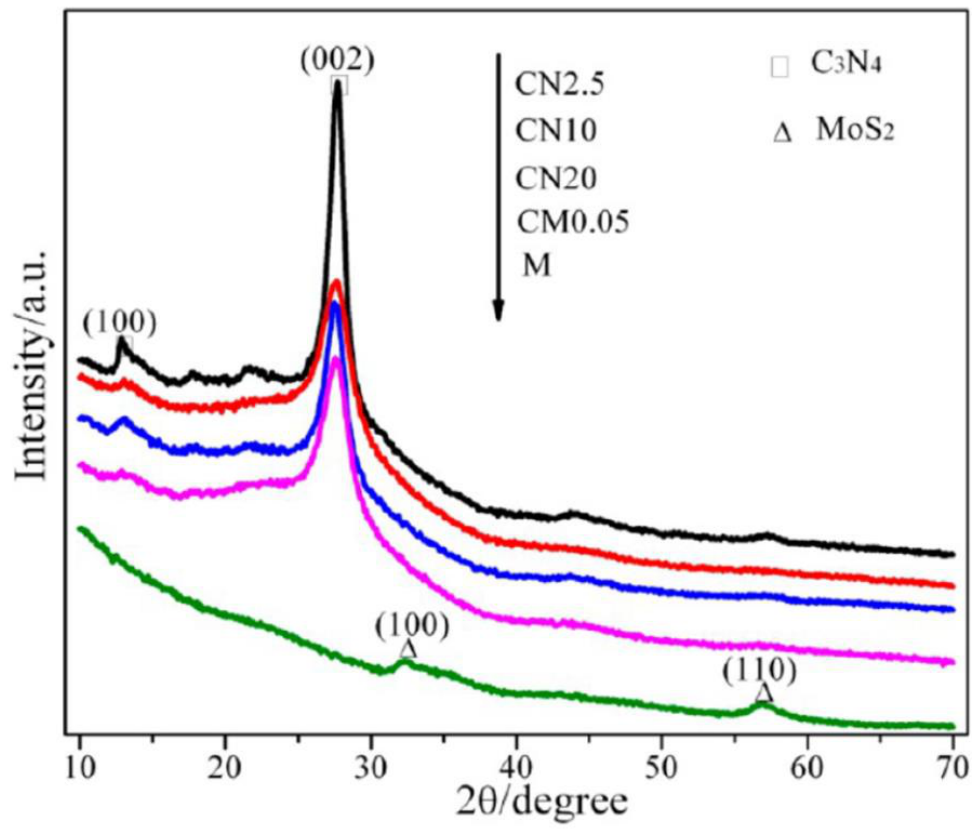
Figure 15. XRD patterns of CN2.5, CN10, CN20, CM0.05, and M (MoS 2 ). Reproduced with permission from